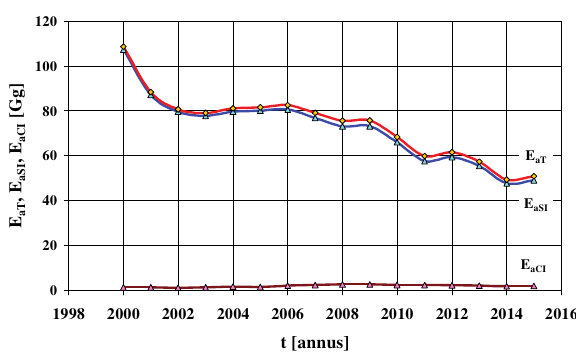
Fig. 6. National annual emission of volatile organic compounds from passenger cars